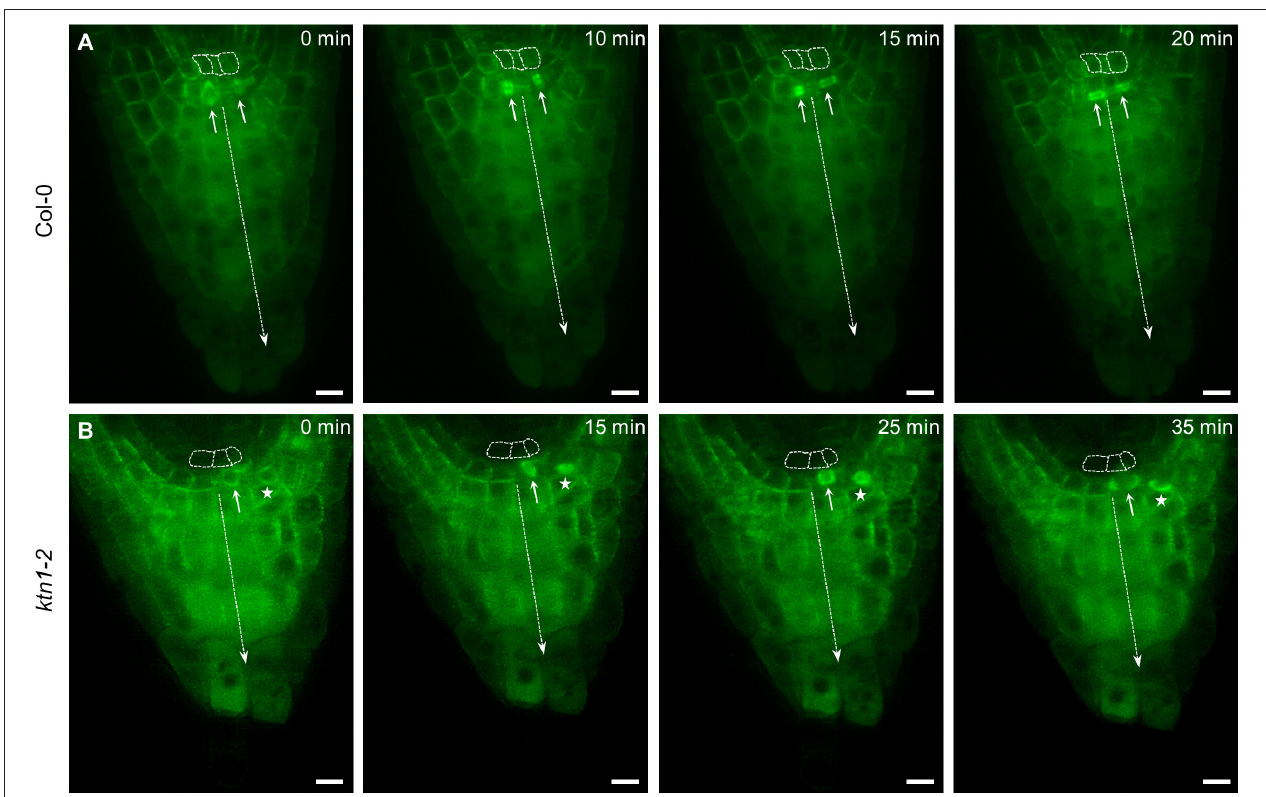
FIGURE 2 | Cell divisions in root columella stem cells (calyptrogen) of Col-0 and ktn1-2 mutant plants stably expressing a GFP-TUA6 microtubule marker. (A) Synchronized proliferative cell divisions (arrows) of columella stem cells in the root apex of Col-0 ( n = 3). (B) Asynchronous proliferative cell division (arrow) on one side of the calyptrogen in the root apex of ktn1-2 mutant ( n = 3). Simultaneous joined cell division of lateral root cap cell (star) beneath of epidermis/lateral root cap initial. Cells of the quiescent center are outlined by dashed line, axis of the columella is indicated by dashed arrow. Time progression of the cell division is indicated in min. Bars: (A,B) 10 µ